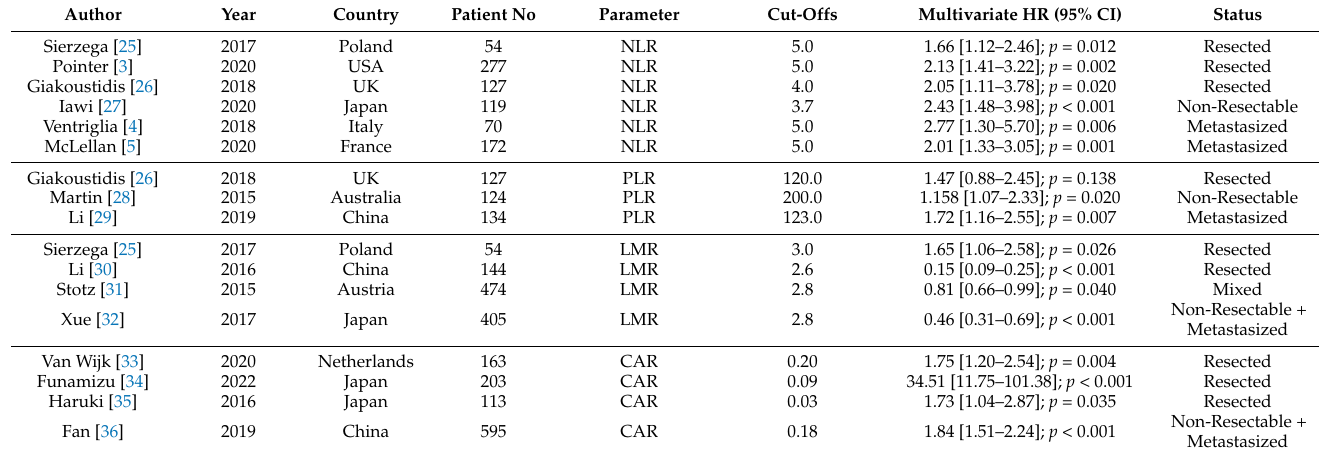
Table 4. Summary of reported retrospective analyses of inflammation-based prognostic indicators in pancreatic